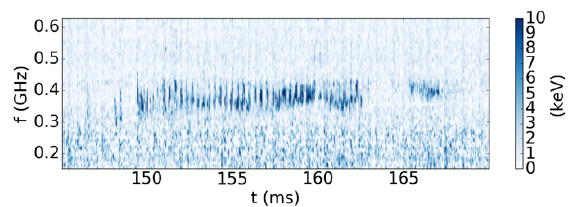
Fig. 2. Example of line-emission of Type 2 (shot #40753).